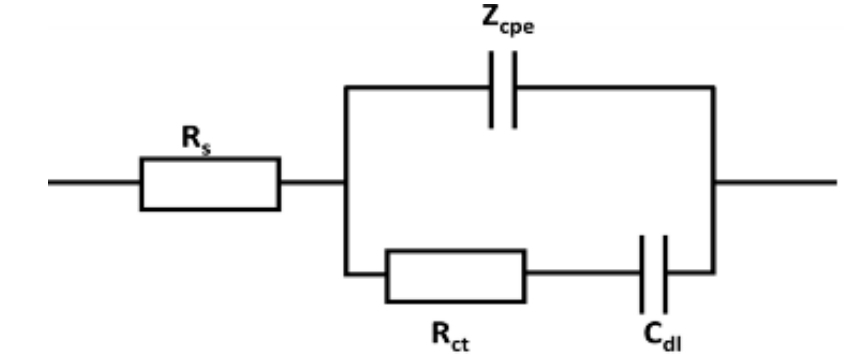
Figure 8. Comparison of the Nyquist plot of the Cr 3 C 2 –NiCr ‐ coated and uncoated SS316 samples at different rotation speeds.